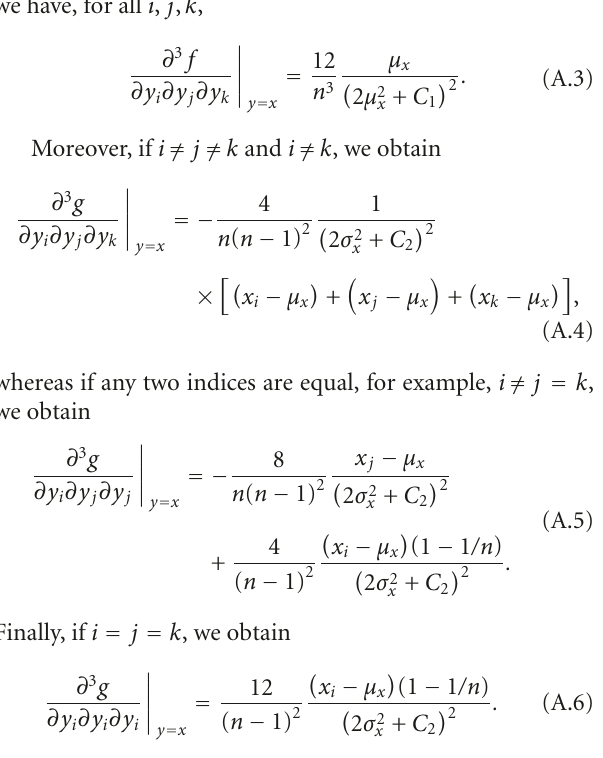
Figure 3: Operational RDF using the JPEG coder on the Lena image under the MSE distortion measure. For comparison we have also shown the high-resolution MSE-RDF (thin line). The horizontal axes on the top and the bottom show the PSNR and MSE,